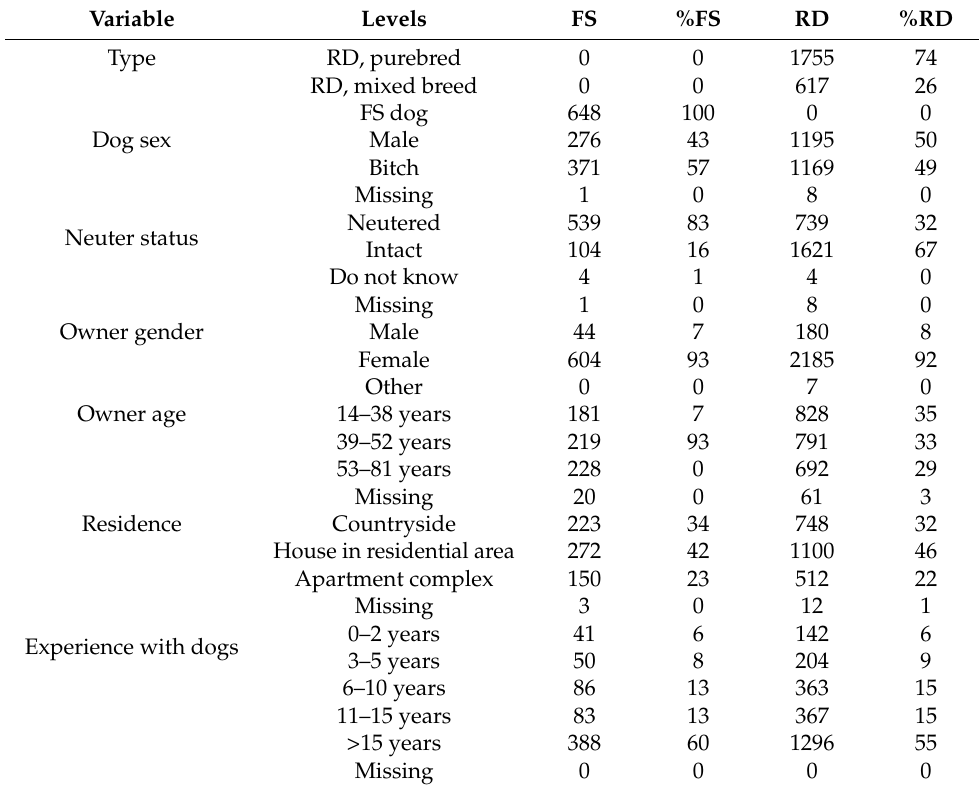
Table 1. An overview of dog and owner variables distributed between the number and percentage of former street (FS) dogs and dogs reared in Denmark